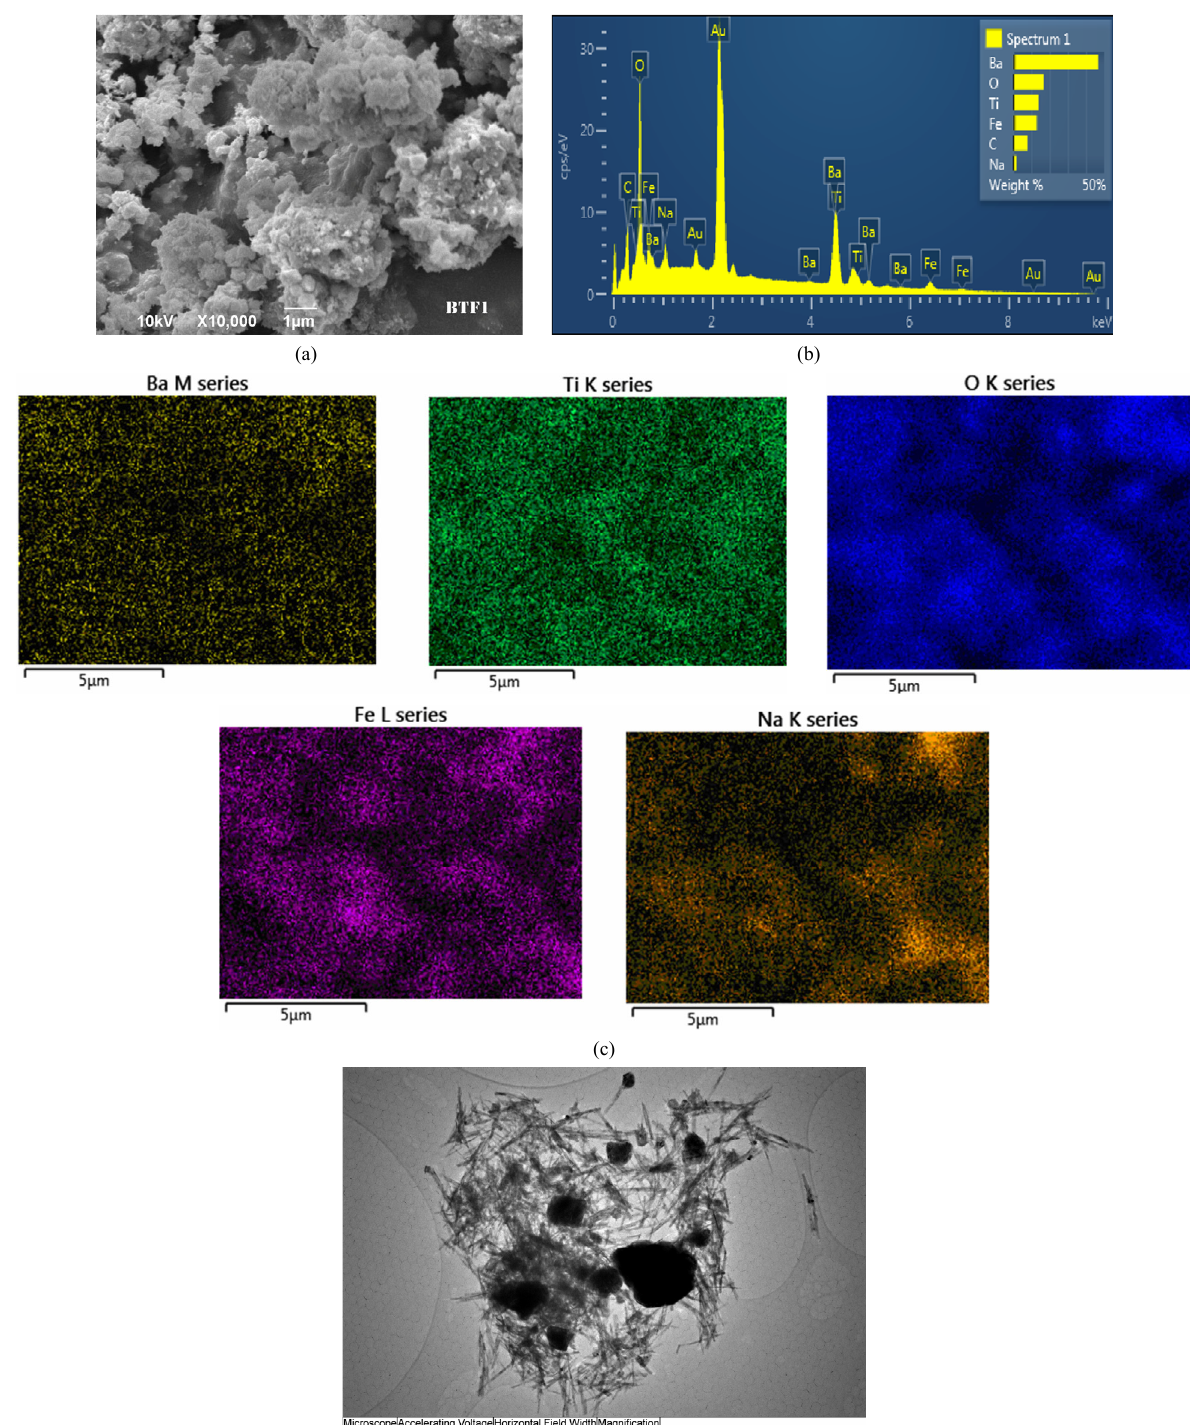
Fig. 4 (a) SEM; (b) EDS; (c) mapping of elements; (d) TEM for the sample